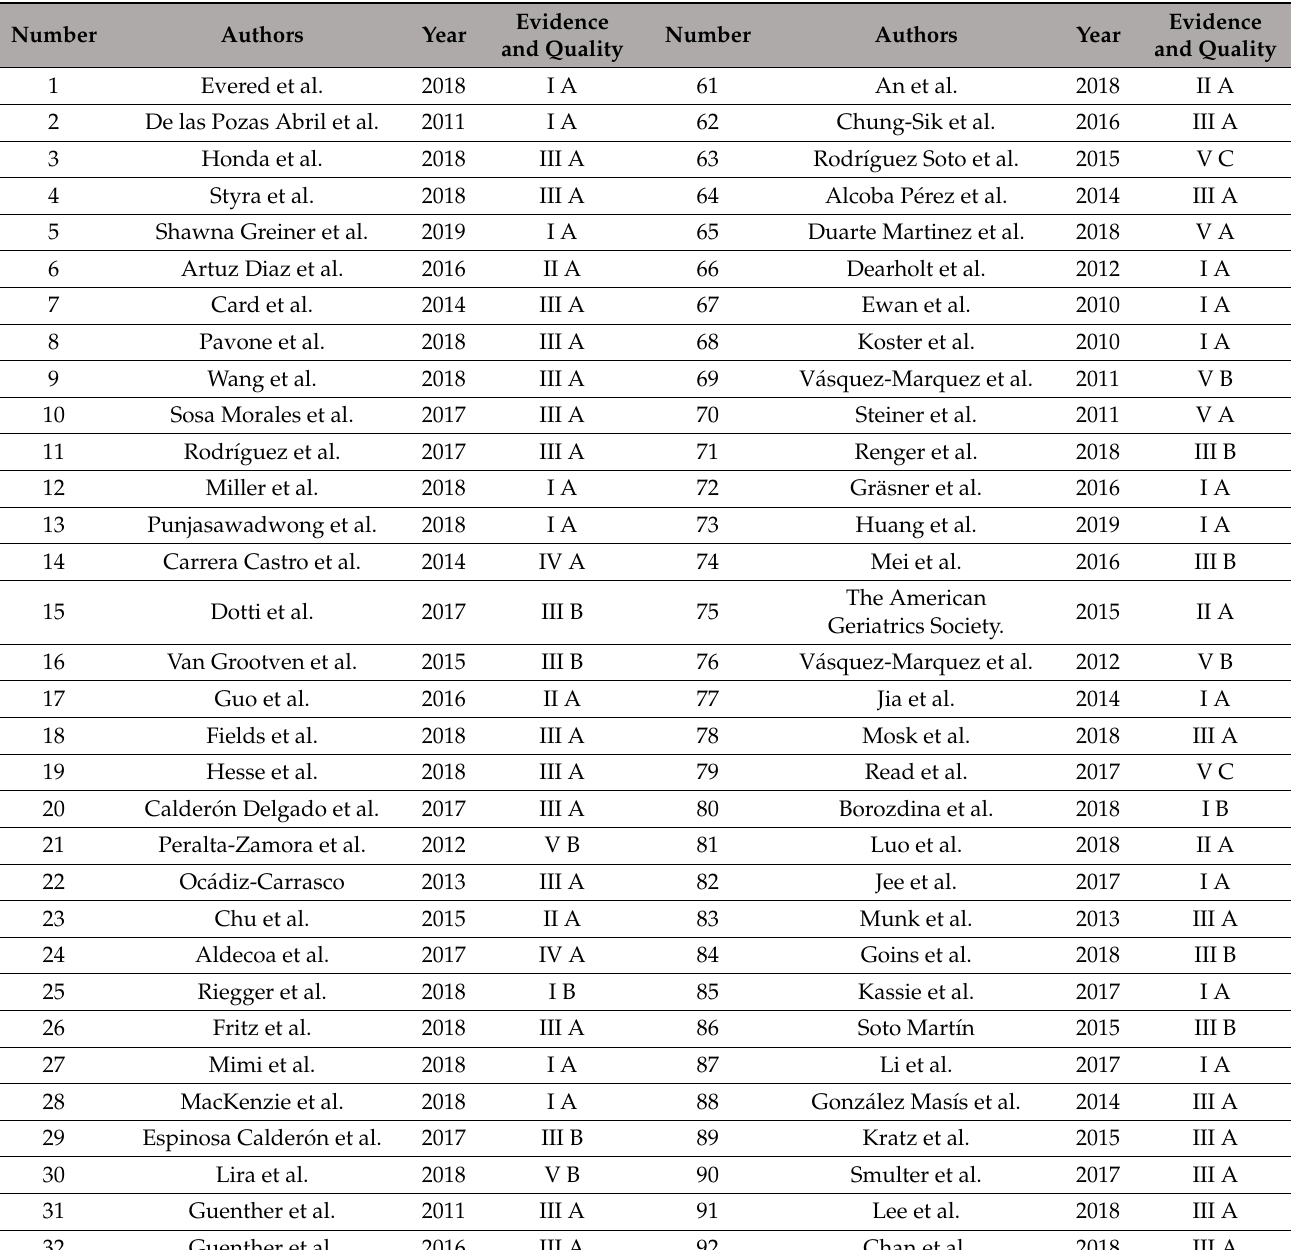
Table 6. Levels of evidence and quality of the included